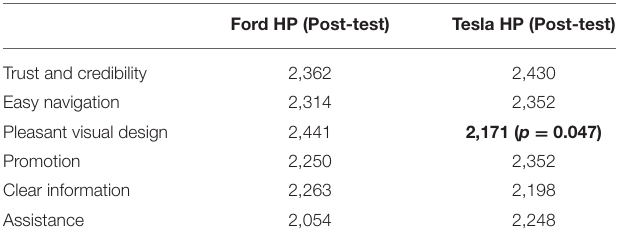
TABLE 8 | Results from heuristic evaluations expressed by means of average percentage scores for each dimension (in bold, the highest differences between the two website average